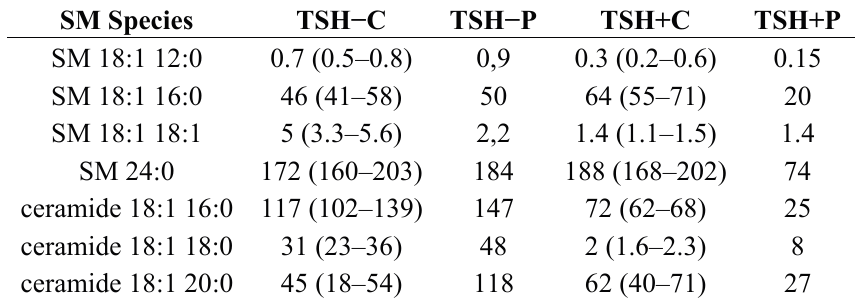
Table 1. Species of sphingomyelin (SM) and ceramide in nuclei of FRTL-5 cells. Data of proton (P) are expressed as ng/µg cholesterol and represent the mean of two samples very similar. TSH − , quiescent cells; TSH+, proliferating cells; C, control; P, proton. Data of control (C) are expressed as mean and range of three independent